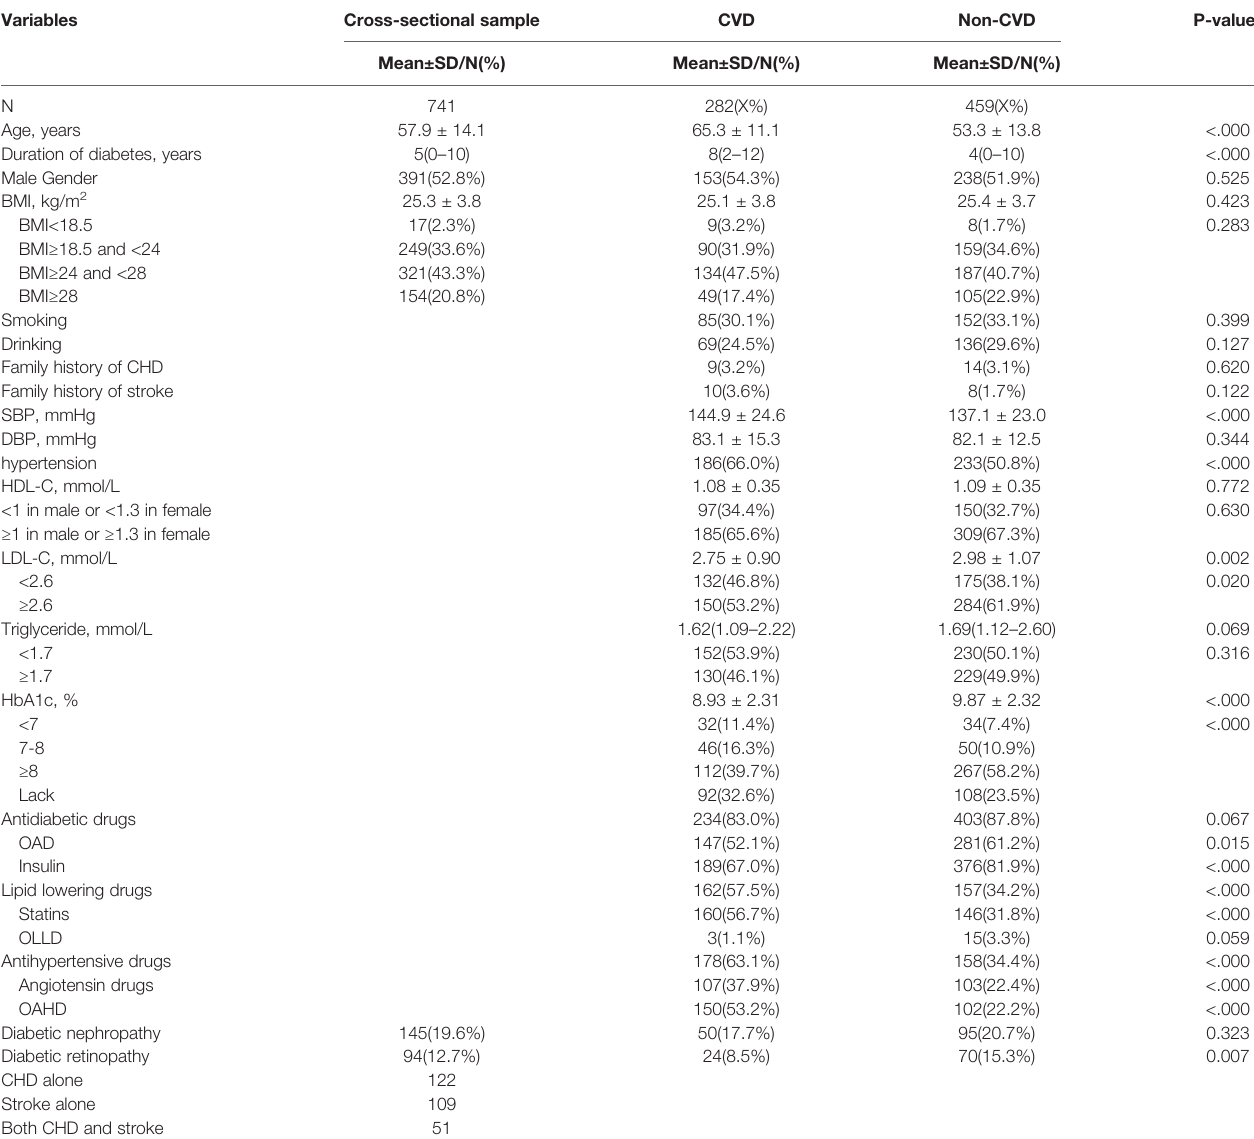
TABLE 1 | Clinical characteristics of patients with type 2 diabetes according to cardiovascular disease status.